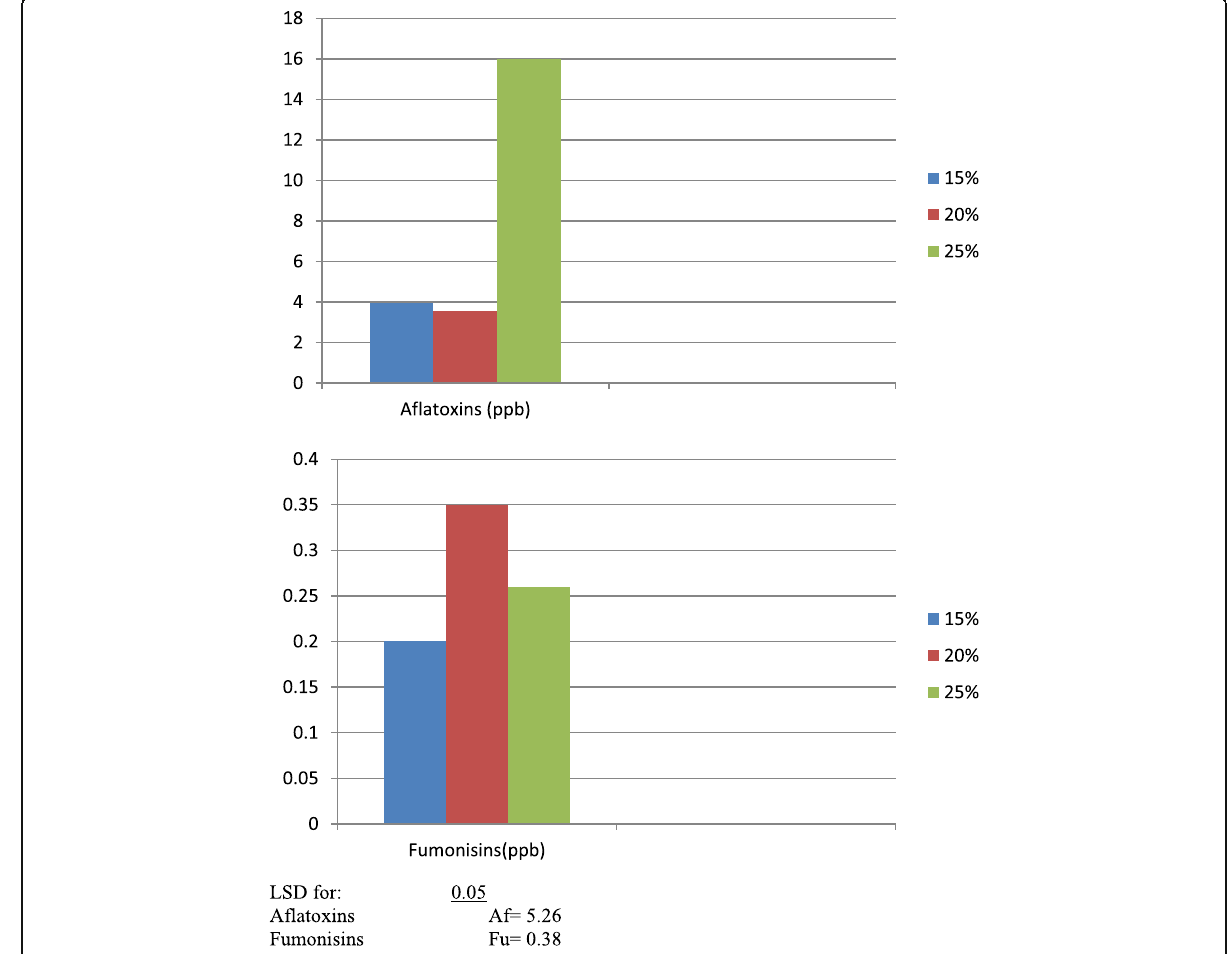
Fig. 3 Effect of three levels of moisture contents (M.C.) on aflatoxins and fumonisins produced by A. flavus and F.